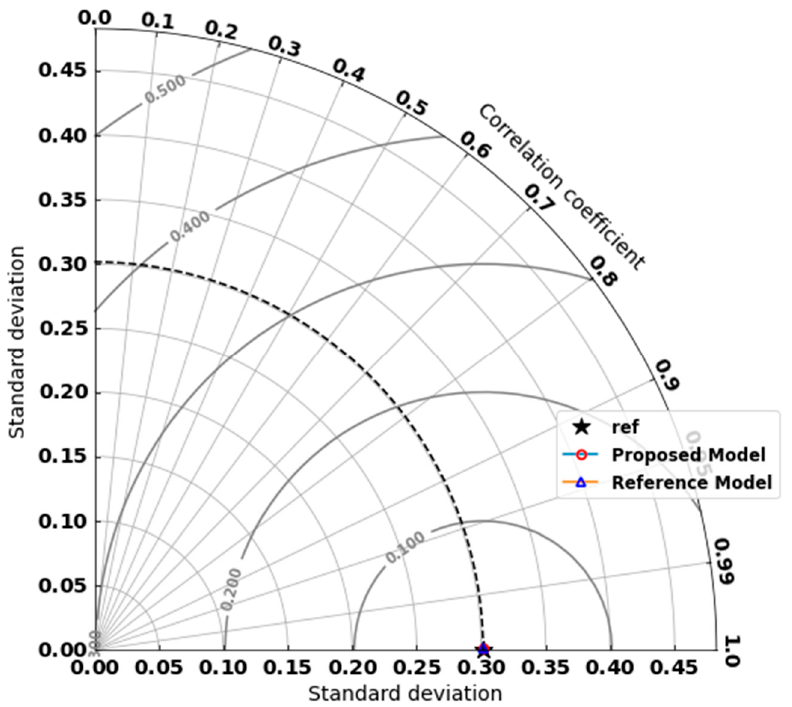
Figure 15. Taylor Diagram showing the standard deviation, correlation, and RMSE of the proposed model and the reference model.